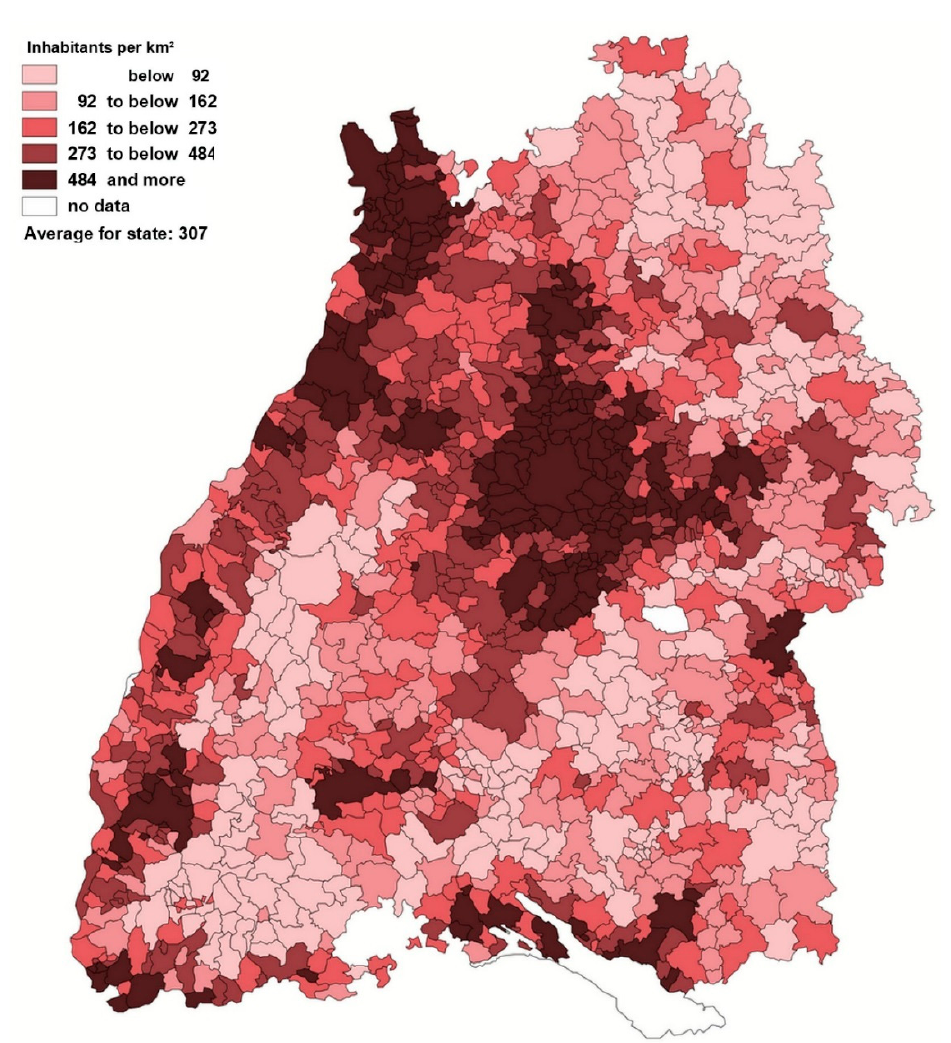
Figure 2. Population density map of Baden-Württemberg [22].